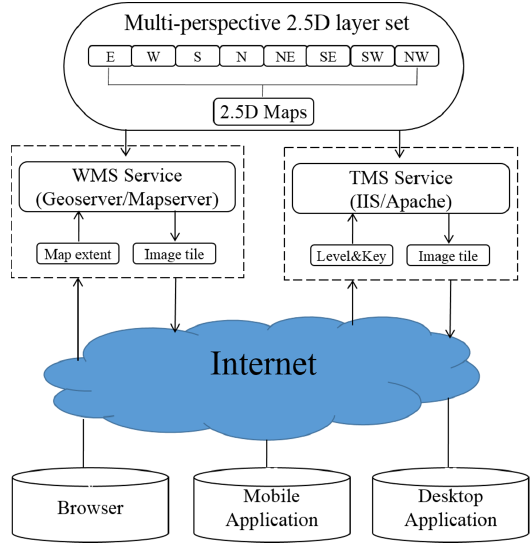
Figure 13. Integrating 2.5D maps into web GIS via map services.